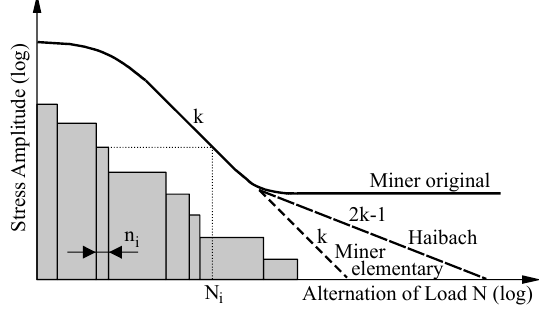
Figure 3: Damage accumulation hypotheses